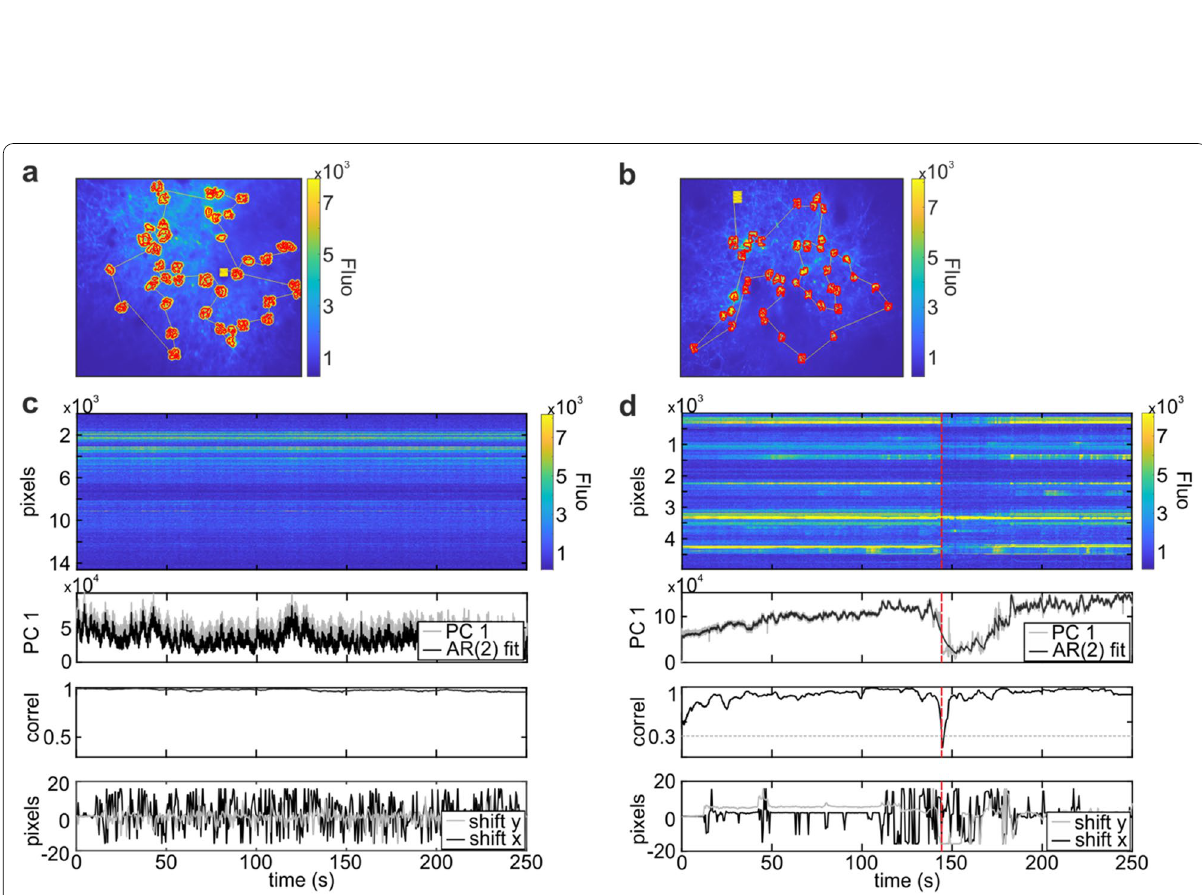
Fig. 3 Large artefacts detection. a , b SLS trajectories (yellow line) with a surround of 4 pixels ( a ) and without surround ( b ) are overlapped to a projection of the corresponding raster acquisition and to their reference segmentation (red ROIs). c , d Large artefact detection for the acquisition in a , b . From top to bottom. Raster of the SLS acquisition. Each row represents the fluorescence trace of a pixel in the trajectory. Pixels are ordered according to their position in the trajectory, from the first (top) to the last (bottom). Reduced representation of SLS dynamics using only the scores vector of the first PC (PC 1, grey line) and fit with an AR(2) model (black line). Correlation between the first PC scores vector and its fit. Displacement along the horizontal (black) and vertical (grey) direction estimated applying the NoRMCorre algorithm [44] to the reference box. The dashed red line in d denotes the detection of a large